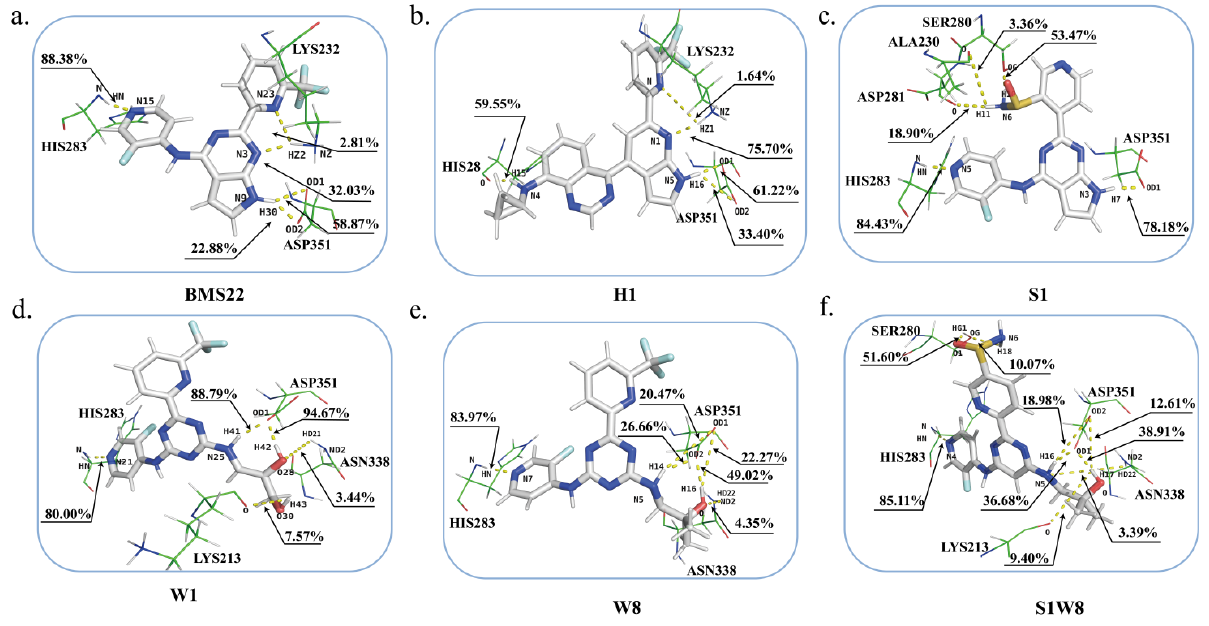
Figure 8 . The 3D diagram of hydrogen bonds between TGFβR Ⅰ and each potential inhibitor: a, b, c, d, e, f are BMS22, H1, S1, W1, Figure 8. The 3D diagram of hydrogen bonds between TGF β RI and each potential inhibitor: ( a – f ) are W8 and S1W8, respectively. BMS22, H1, S1, W1, W8 and S1W8,